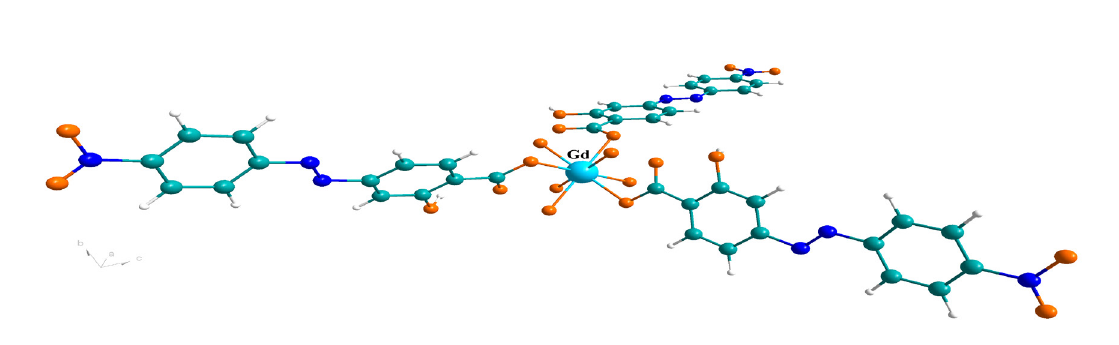
Fig. 2. The optimized structure of [Gd(L)